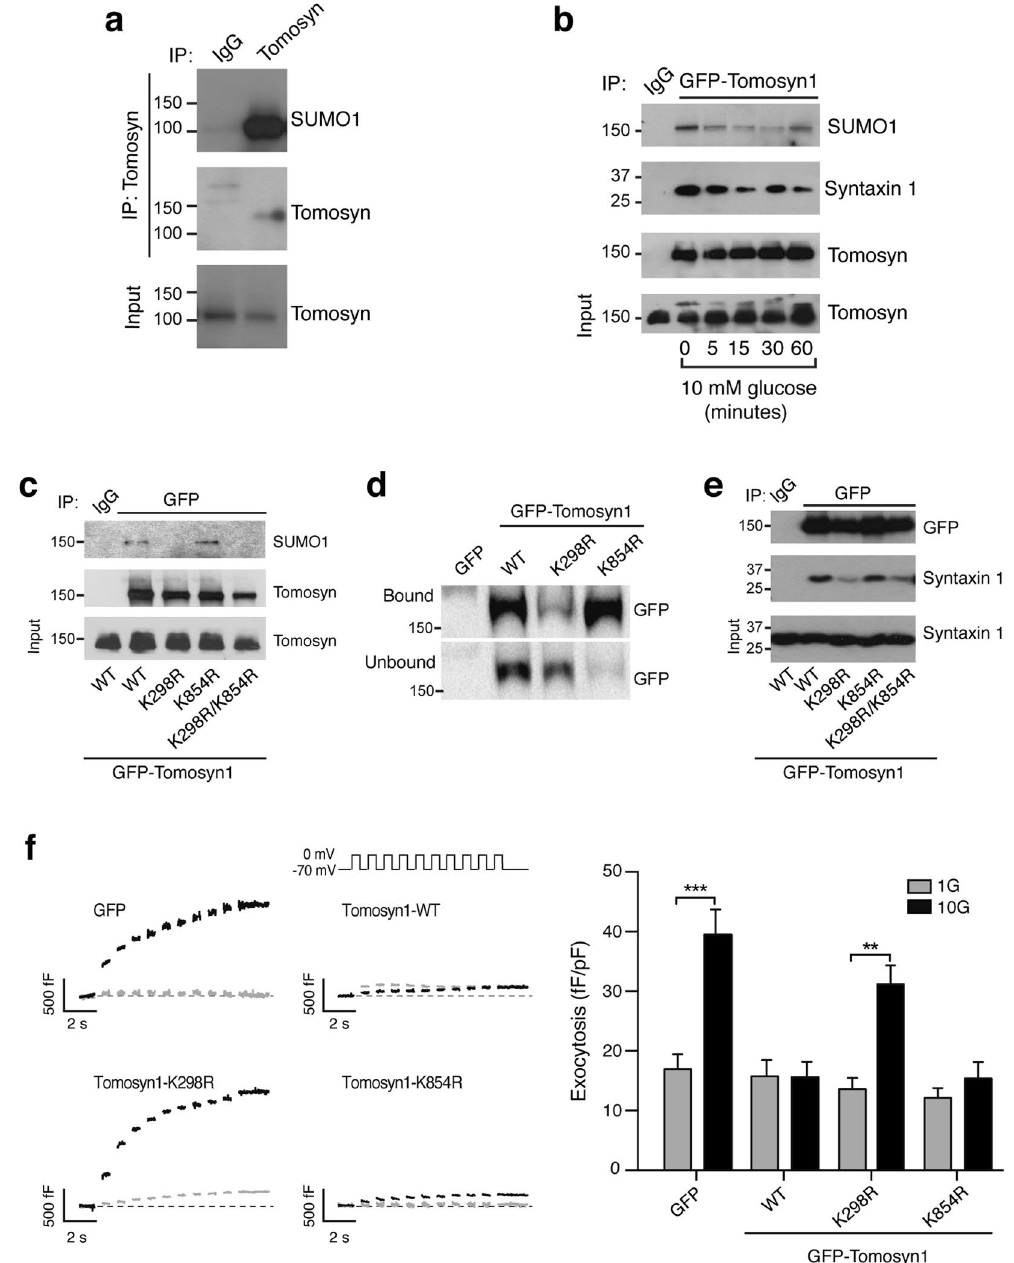
Figure 1. SUMOylation is required for tomosyn function in ß cells. ( a ) Pull-down of native tomosyn demonstrates the co-immunoprecipitation of SUMO1 in INS 832/13 cells (representative of n = 4). ( b) Glucose- stimulation at the indicated time causes the de-SUMOylation of GFP-tomosyn1 and reduced syntaxin1 binding in INS 832/13 cells (representative of n = 3). ( c) Co-immunoprecipitation of protein lysates from INS 832/13 cells expressing GFP-tomosyn1 demonstrate K298 as a site for SUMO1 modification (representative of n = 3). ( d) K298R reduces the interaction of GFP-tomosyn1 and TAT-Hisx6-SUMO1 captured by Ni-NTA resin in INS 832/13 cells (representative of n = 4). ( e) Loss of tomosyn1 SUMOylation in the K298R mutant results in reduced binding to syntaxin1 (representative of n = 3). ( f) The wild-type GFP-tomosyn1 (WT) and the K854R mutant reduces the glucose-dependent amplification of exocytosis from human β -cells, however the K298R mutant lacks this suppressive effect (n = 35–46, from 4 donors). 1 mM glucose (1G, grey traces/bars) and 10 mM glucose (10G, black traces/bars). ** p < 0.01, and *** p <